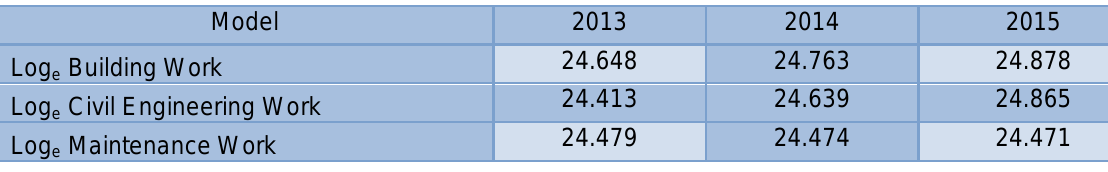
Table 2 Forecasted Construction Outputs